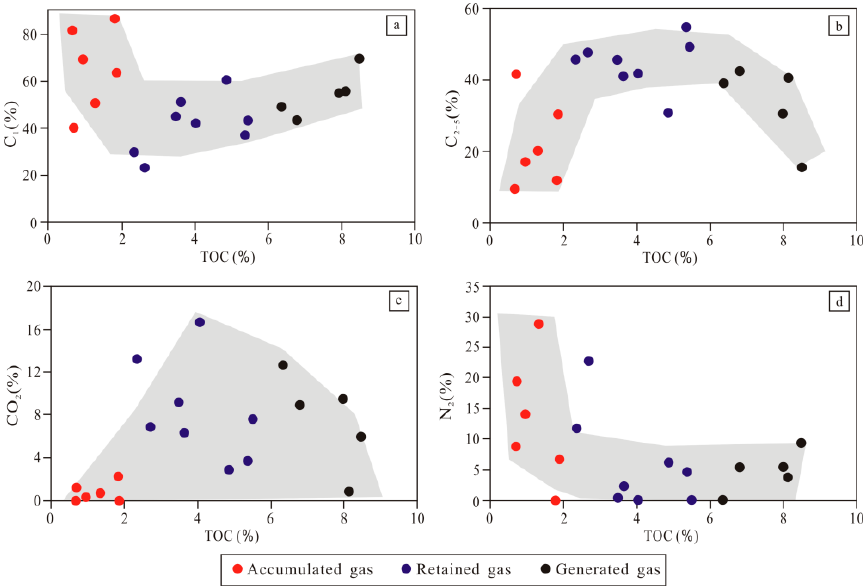
Figure 10. Relationship between TOC and different gases. ( a ) Relationship between CH 4 and TOC; ( b ) Relationship between heavy gases and TOC; ( c ) Relationship between CO 2 and TOC; ( d ) Relationship between N 2 and TOC;